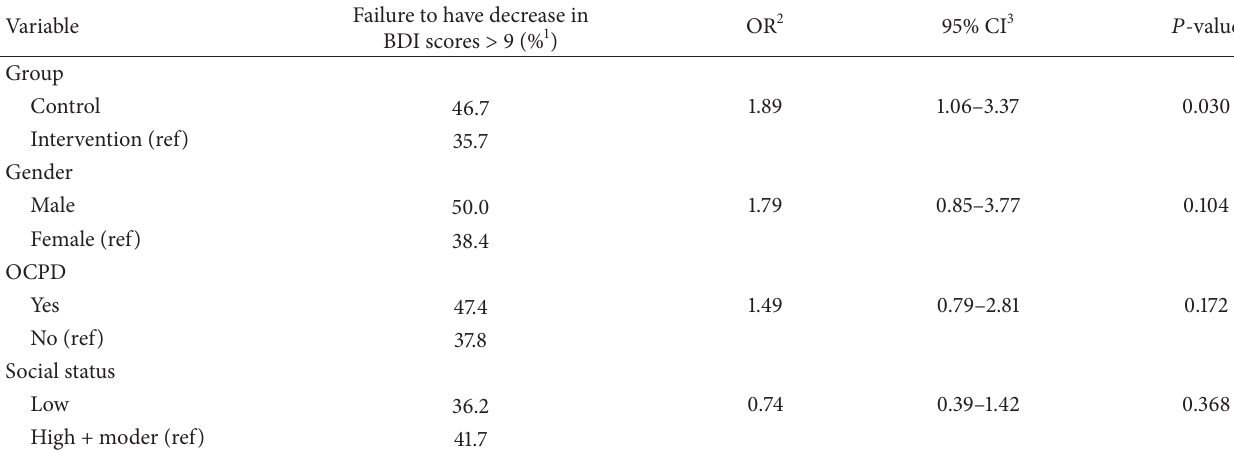
Table 4: The effect of the intervention on changes in the BDI scores, using the logistic regression